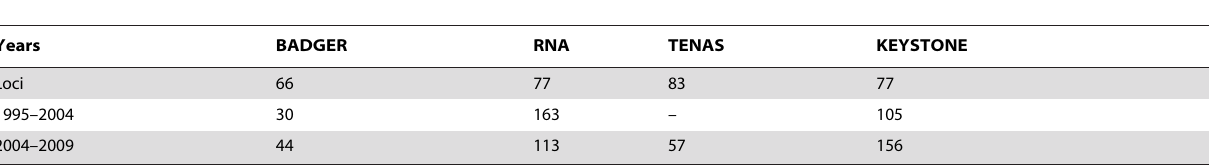
Table 7. Estimated population sizes ( ^ NN e ) of the four locations over the three sampling years.